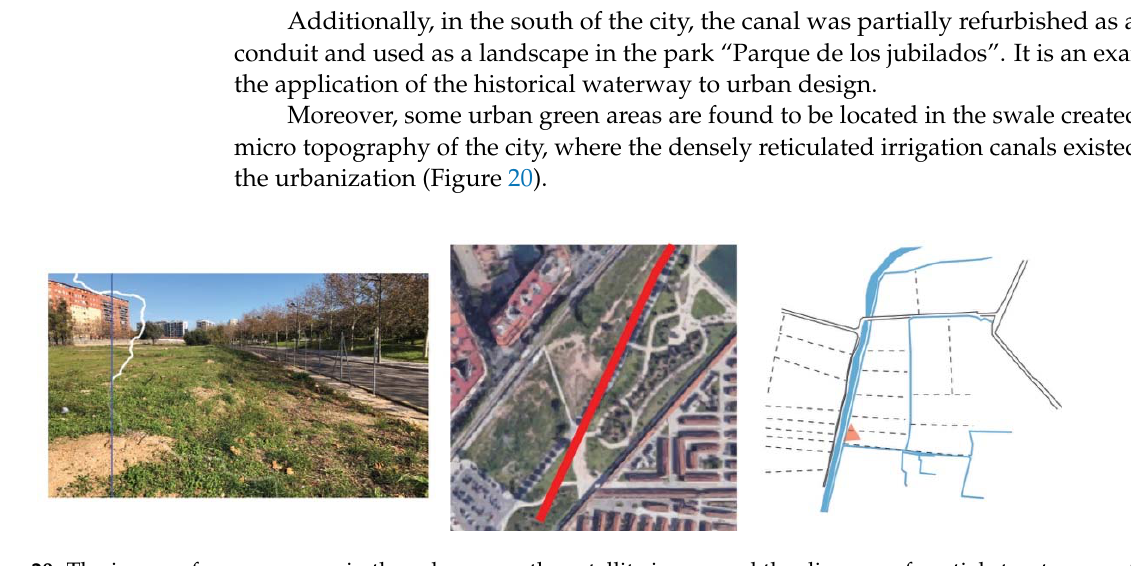
Figure 20. The image of a green space in the urban area, the satellite image and the diagram of spatial structure created based on the cadaster created between 1929 and 1946 at the same location.